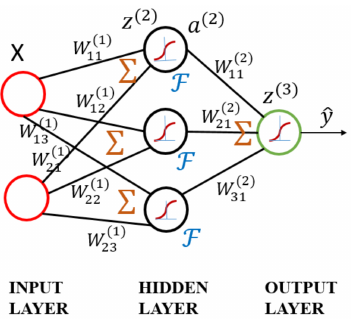
Figure 7. Schematic diagram of artificial neural